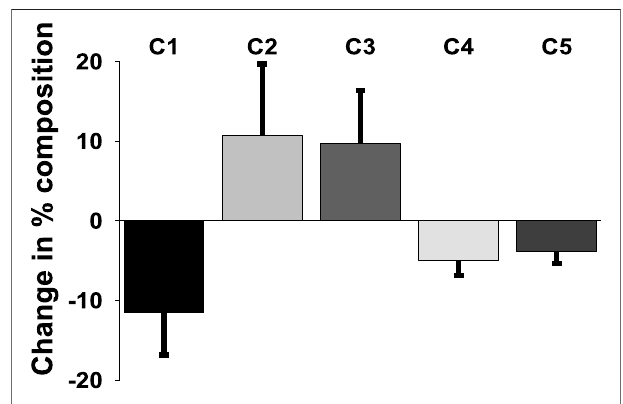
FIGURE 5 | Average difference in the percentage of PARAFAC components (whole-sample EEMs — EEMs measured at M p ). Error bars show 95%